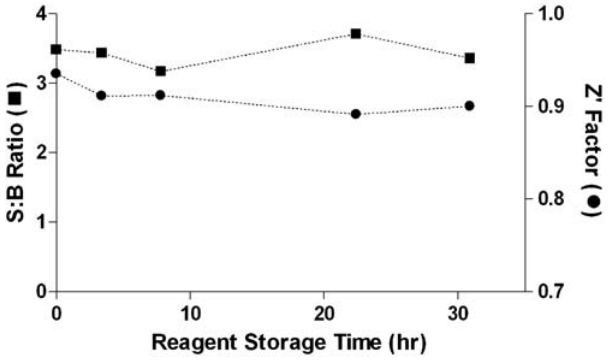
Figure 2. Screening reagents’ stability as a function of storage time. Bottles containing buffer, enzyme, and substrate stock solutions, respectively, were prepared and kept at 4 u C. At the selected time points, the bottles were connected to a liquid dispenser and the assay was performed as described in Methods. Signal-to-background ratio (S:B) and Z 9 factor were computed as the average of 32